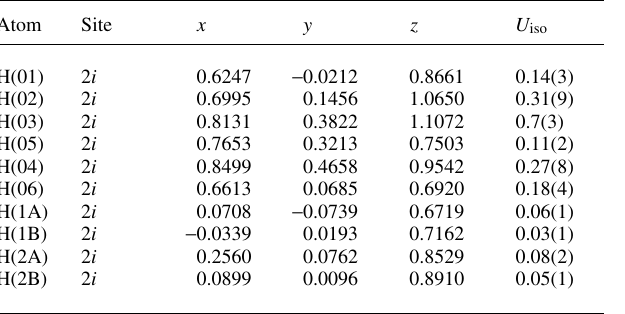
Table 2. Atomic coordinates and displacement parameters (in Å 2 ) .